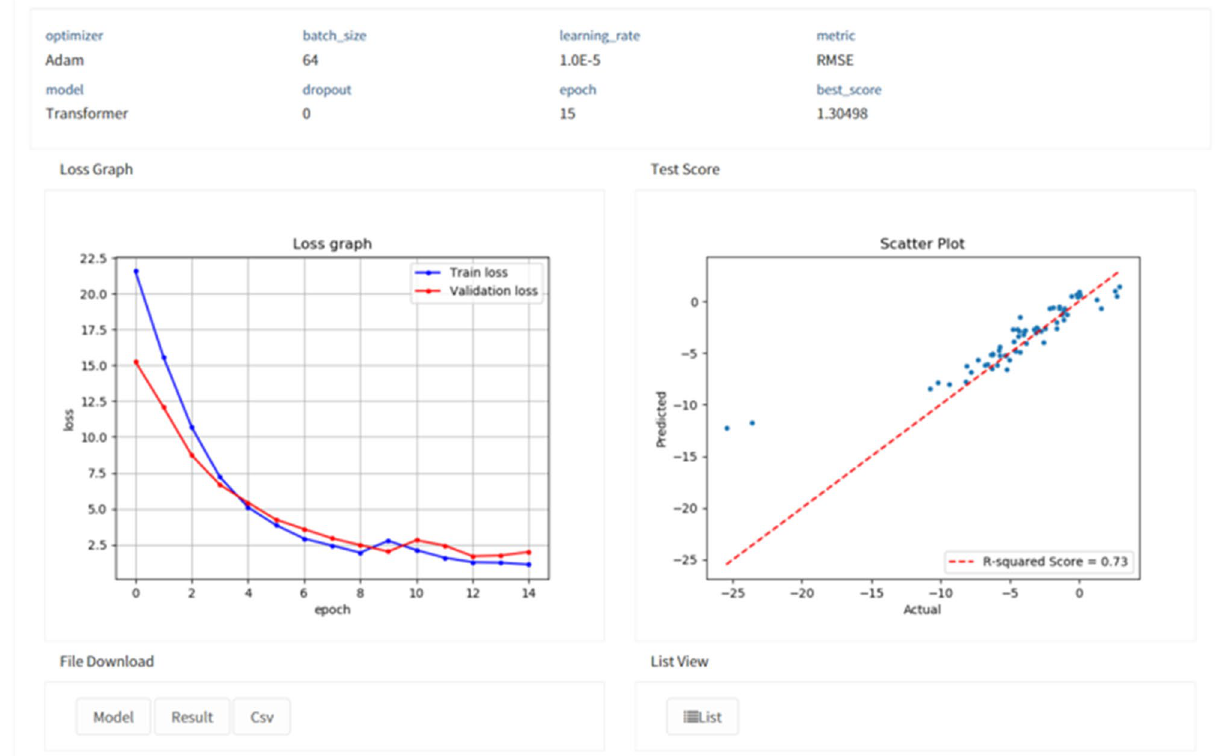
Figure 5. The result of the fine-tuning service. The result contains hyperparameters of the model, loss graph and performance on test set. Users can export the result and the